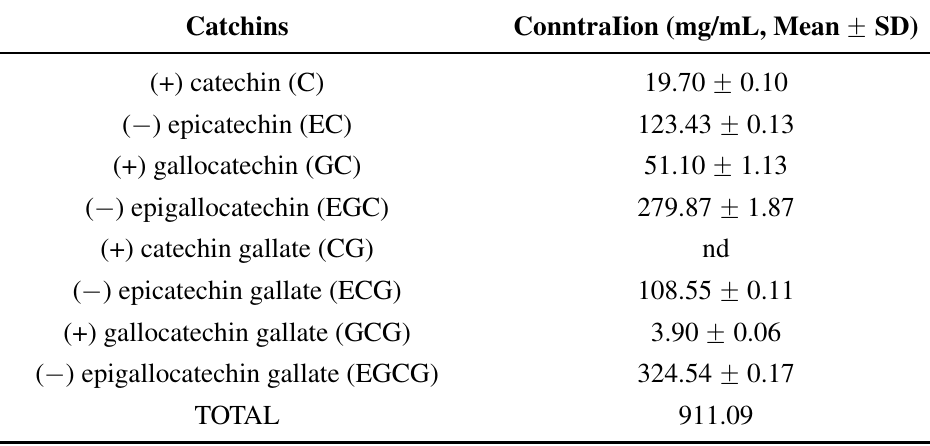
Table 2. The composition of polyphenols in green tea leaves determined by high performance liquid chromatography (HPLC) (adapted from